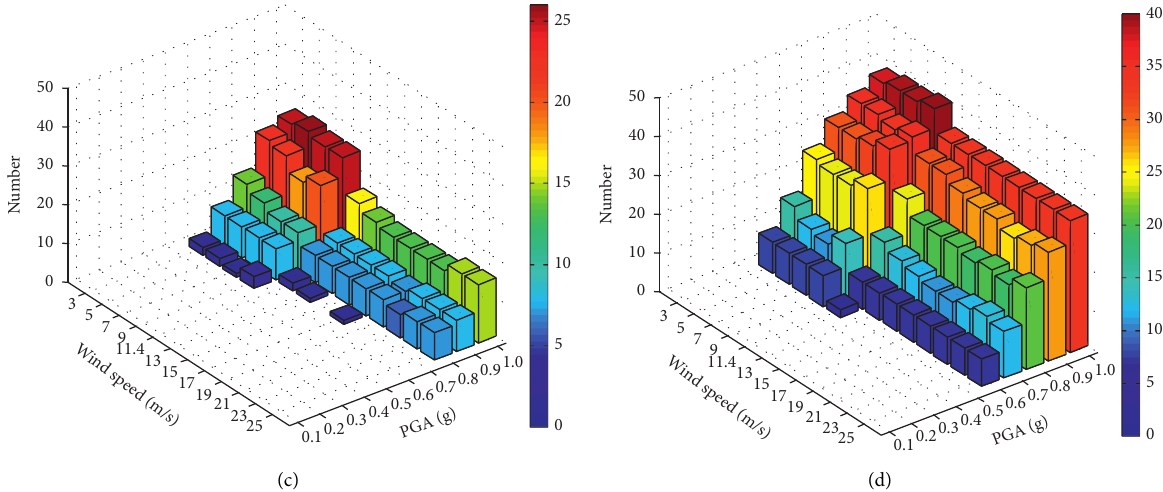
Figure 8: The number of exceeding specified critical levels for different wind speeds and PGA in model 2: (a) MY, (b) ML, (c) DY, and (d) DL.